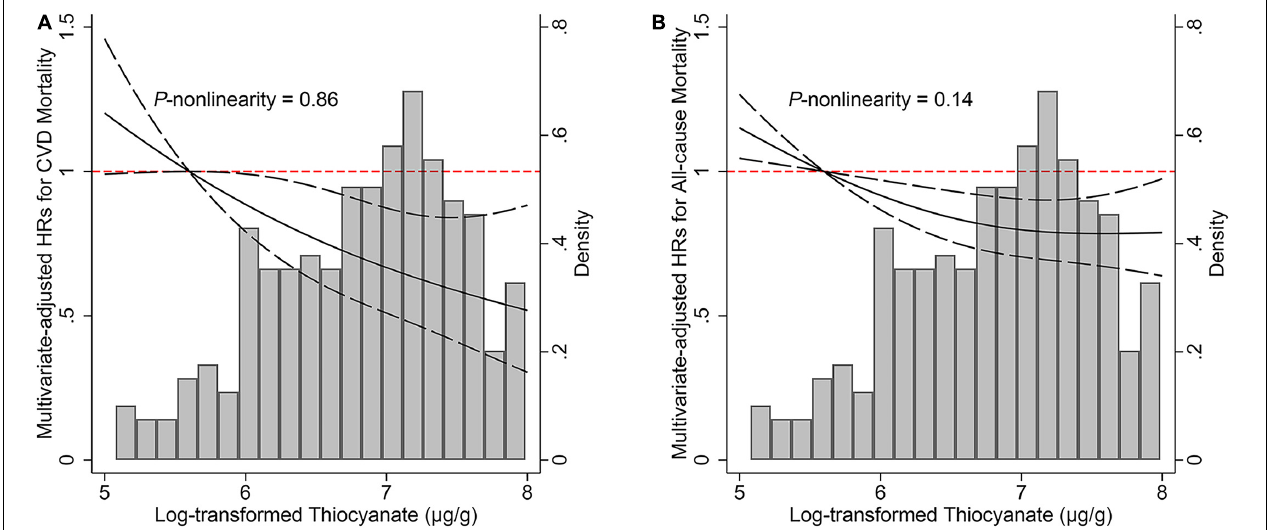
FIGURE 1 | Associations of urinary thiocyanate levels with (A) cardiovascular disease and (B) all-cause mortality among non-smokers. Hazard ratio was represented by solid line and 95% confidence intervals were represented by dashes. Model was adjusted for age (years, continuous), sex (male, female), race/ethnicity (non-Hispanic white, non-Hispanic black, Mexican American, others), secondhand smoking (yes, no), body mass index ( < 25, 25- < 30, ≥ 30 kg/m 2 ), education attainment (under high school, high school, above high school), family poverty income ratio ( < 1.3, 1.3- < 3.5, ≥ 3.5), alcohol consumption (never, former, current), physical activity (never, moderate, vigorous), total energy intake (kcal, continuous), Healthy Eating Index-2015 score (continuous), urinary iodine ( < 100 µ g/L, ≥ 100 µ g/L), and hypertension (yes, no). CVD, cardiovascular disease; HR, hazard ratio.